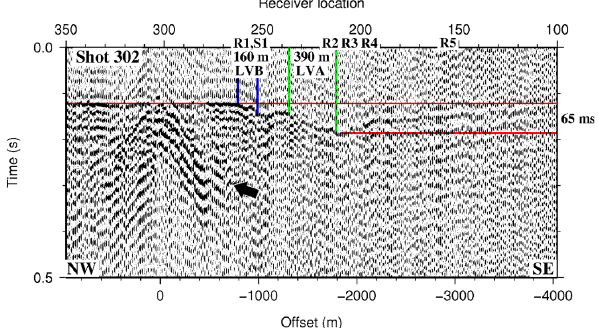
Fig. 12. Shot-gather 302 from S.P. 2 plotted using a reduction ve- locity of 5000ms − 1 and without refraction statics correction. Two zones display a sharp delay in the first arrivals and are marked as LVA and LVB. Total accumulated delay is 65ms across the two zones. Southeast dipping reflections S1, R1–R5 not seen in this shot-gather, are marked. Black arrow indicates where surface waves